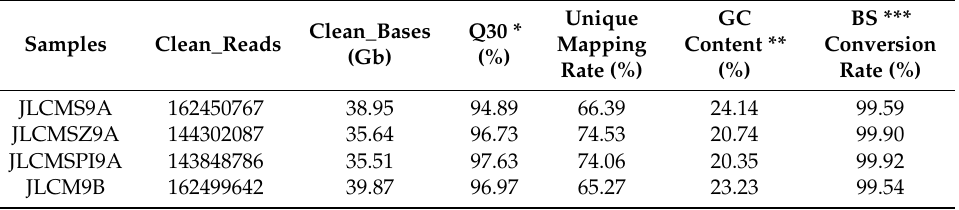
Table 1. WGBS of soybean A-lines and B-line data summary and alignment statistics with reference genome.